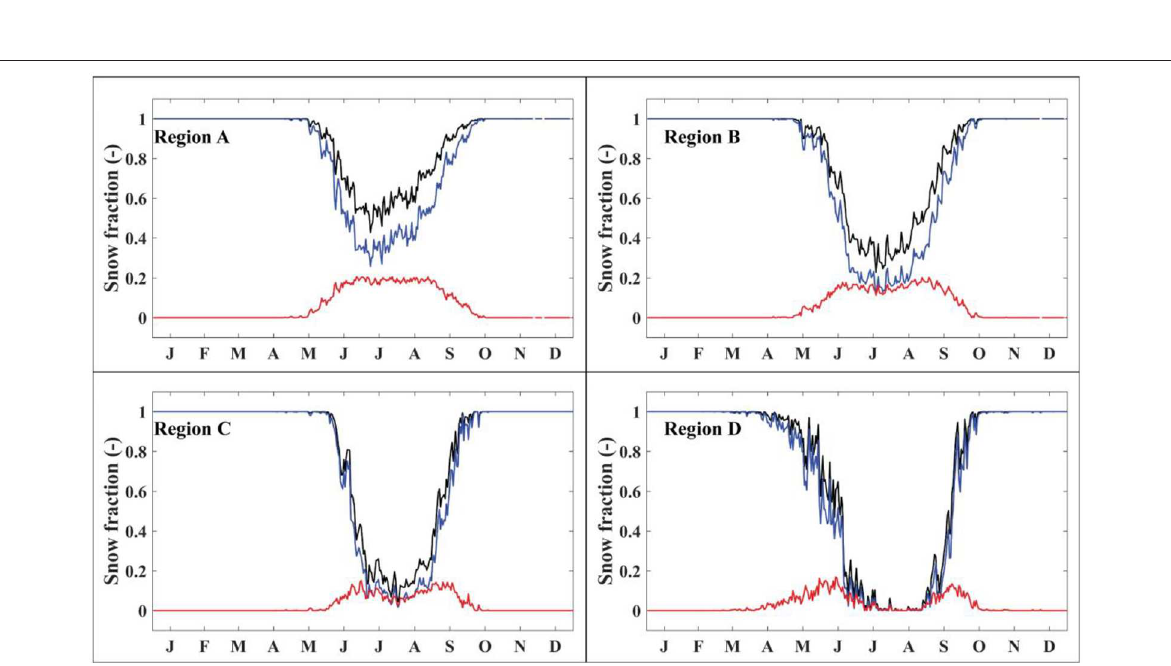
Frontiers in Earth Science | www.frontiersin.org